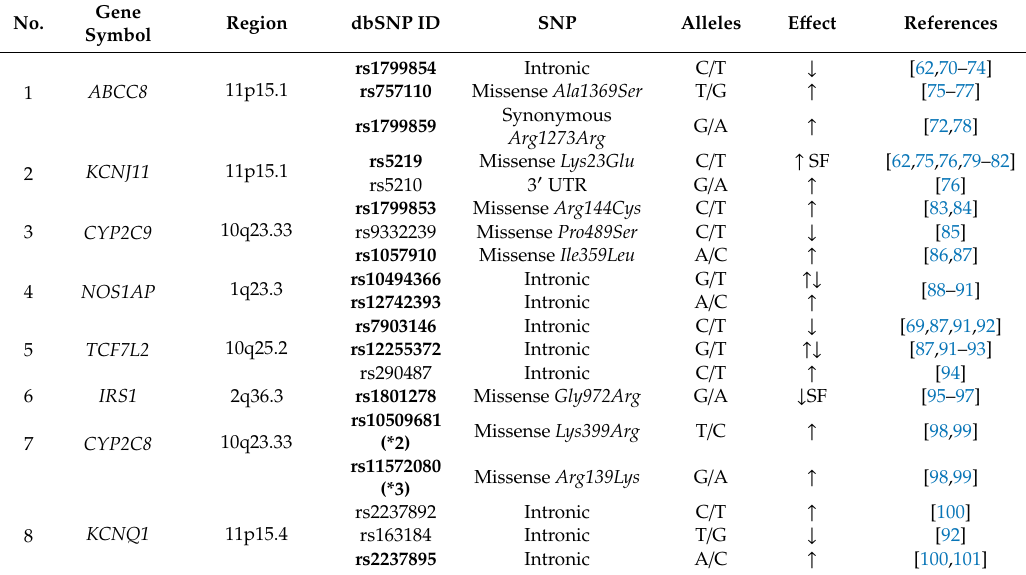
Table 2. Genetic variants that influence sulfonylureas / meglitinides therapy